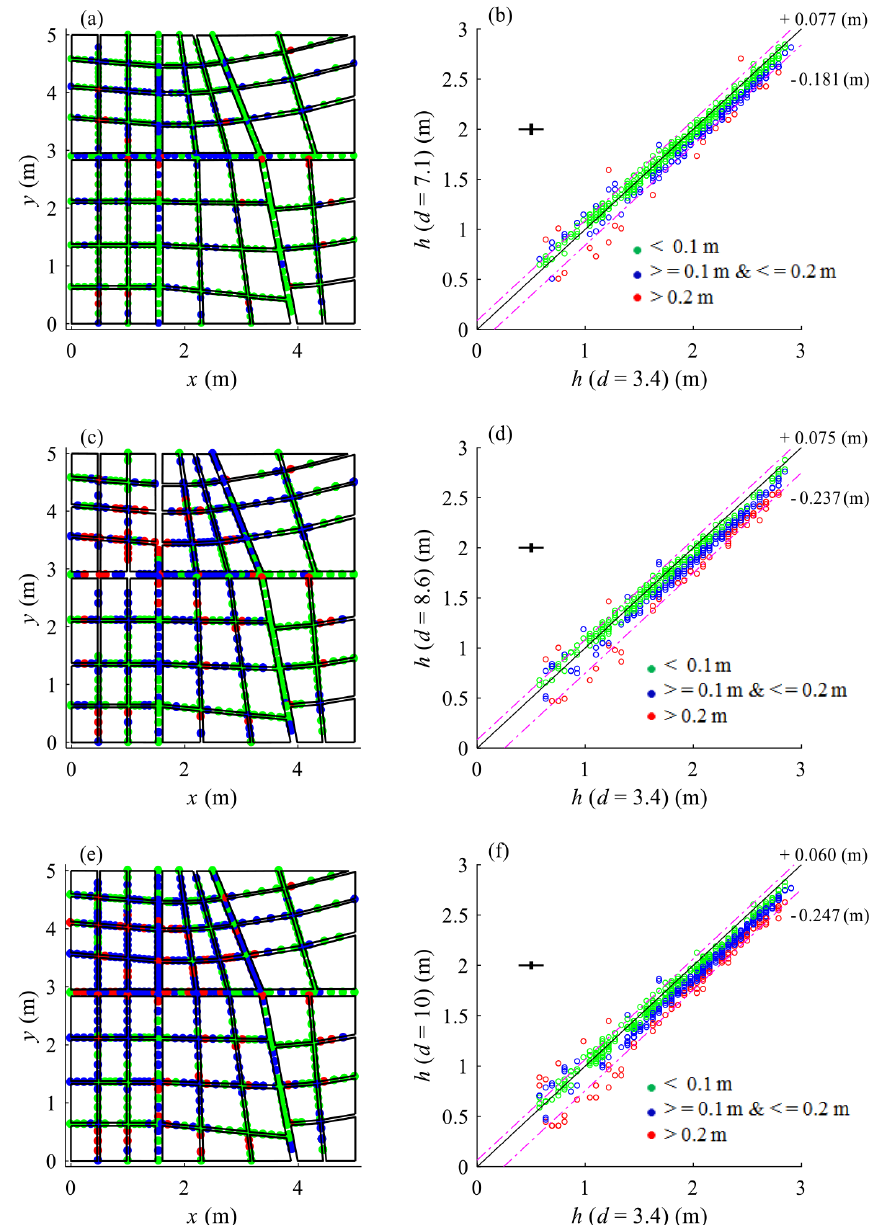
Figure 4. Spatial distributions (a, c, e) and scatter plots (b, d, f) of the differences between the upscaled water depths in Run 3 ( d = 7 . 1), 2 ( d = 8 . 6) and 1 ( d = 10), and those derived from Run 4 ( d = 3 . 4) from Araud (2012). The dashed purple lines indicate the range containing 90% of the